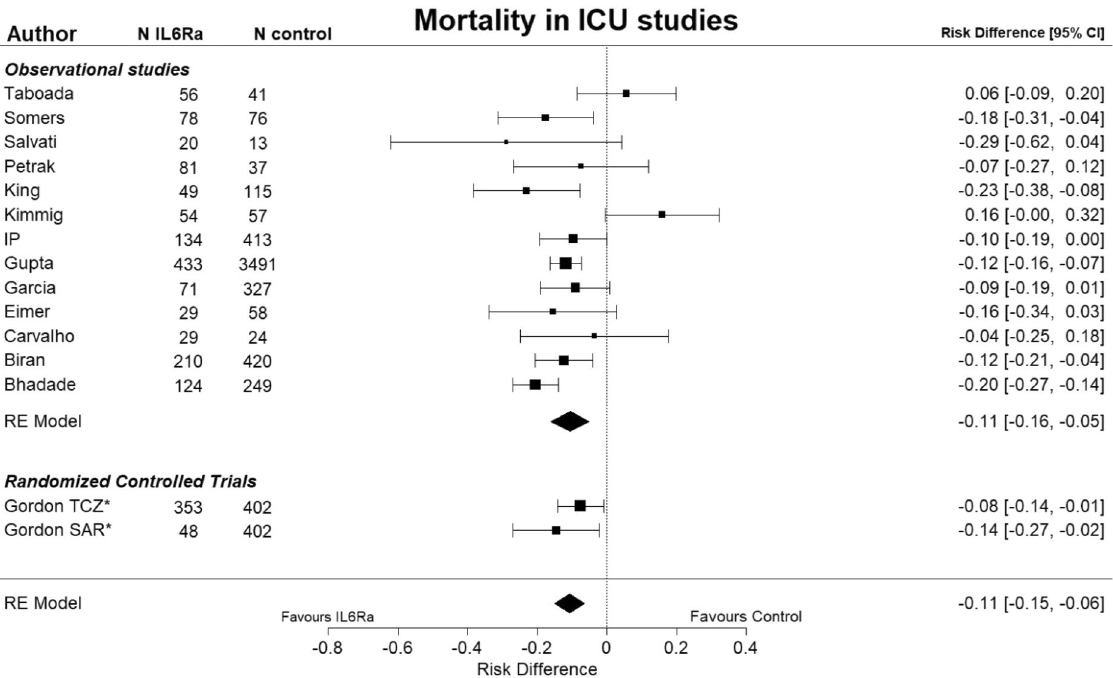
Figure 2. Forest plot showing the risk difference for studies in ICU setting in mortality between patients treated with IL-6 (receptor) antagonists and patients not treated with IL-6 (receptor) antagonists. I 2 was 0%. The Metafor R package was used to generate this figure 13,23 . IL6Ra = IL-6 (receptor) antagonist, TCZ = tocilizumab, SAR = sarilumab, * = RCT.